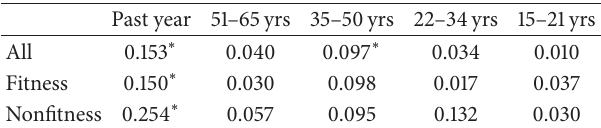
Table 1: Mean ( ± SD) descriptive characteristics of fitness and nonfitness participants.